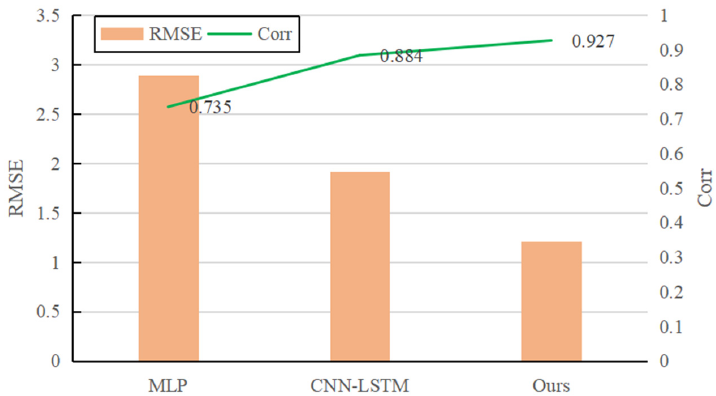
Figure 10. Performance comparison of different models.